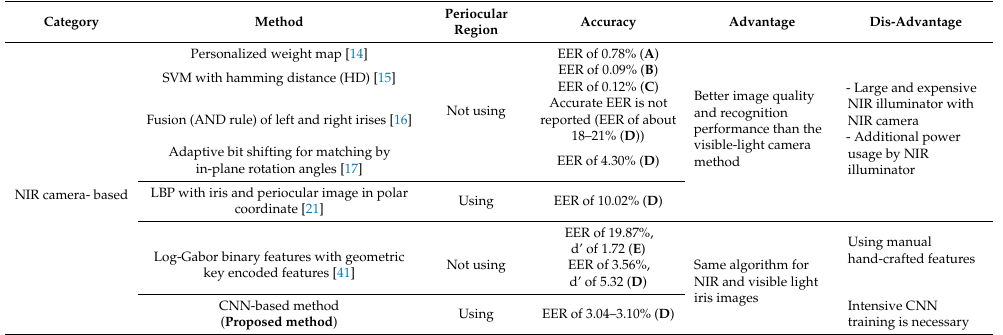
Table 1. Comparison of existing recognition methods and the new method proposed by this study ( d’ means the d -prime value of Equation (4). EER means equal error rate, and its concept is explained in Section 3.4). LBP, local binary patterns; RBWT, reverse biorthogonal wavelet transform;